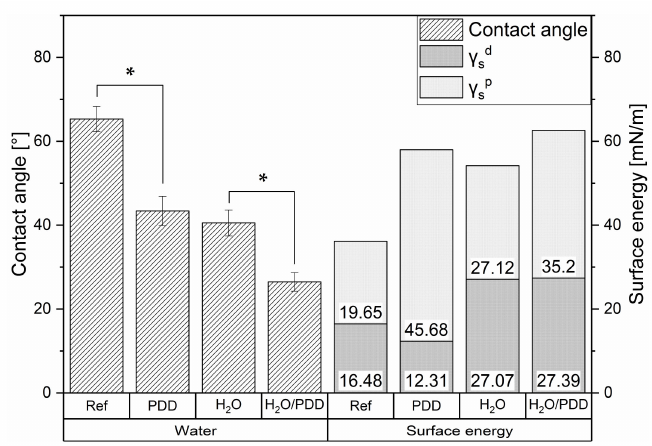
Figure 5. Comparative plot of the resulting contact angle of water ( n ≥ 10, ANOVA tested, p = 0.05 indicated by *) and calculated surface energies on dentin (Ref), wet dentin (H 2 O), and after the surface modification via atmospheric PDD plasma (PDD & H 2 O/PDD) (18 W, 120 s, 10 mm).